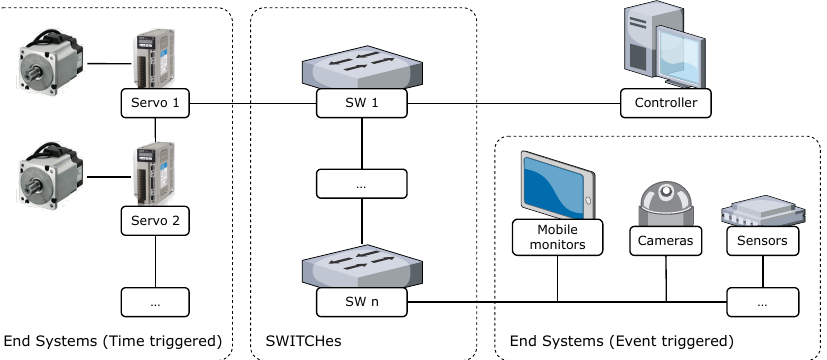
Figure 1. The architecture of a TSN in a smart factory and the composition of the TSN